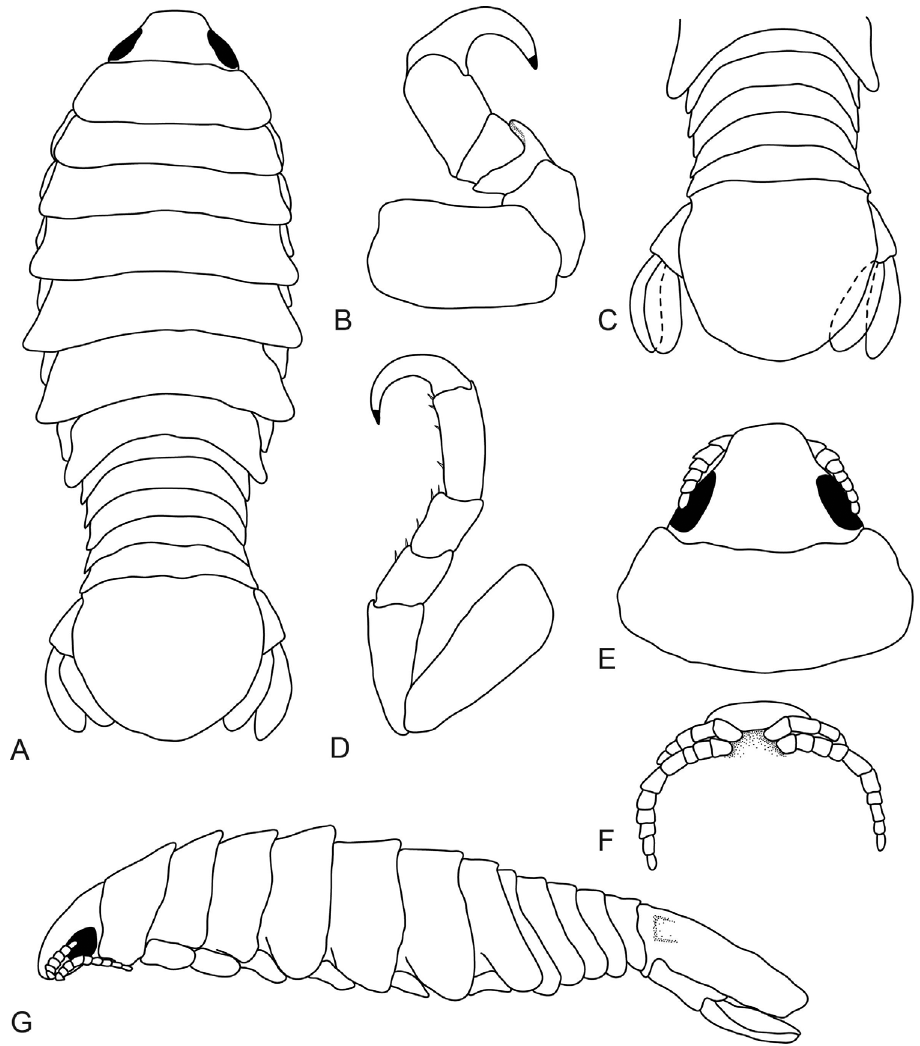
Figure 7. Anilocra brillae sp. n. transitional stage (11 mm): A dorsal view B pereopod 1 C dorsal pleo- telson D pereopod 7 E dorsal view of cephalon F ventral view of cephalon G lateral view. Pereopods gradually increasing in size towards posterior. Pereopod 6 basis 1.7 times as long as greatest width; ischium 0.7 times as long as basis; propodus 1.5 times as long as wide, dactylus 2.3 times as long as propodus, 3.8 times as long as wide. Pereo- pod 7 basis 3.0 times as long as greatest width; ischium 0.7 times as long as basis, without protrusions; merus proximal margin without bulbous protrusion, 2.0 times as long as wide, 0.7 times as long as ischium; carpus 1.5 times as long as wide, 0.6 times as long as ischium, without bulbous protrusion; propodus 3.2 times as long as wide, 0.8 times as long as ischium; dactylus moderately slender, 0.9 times as